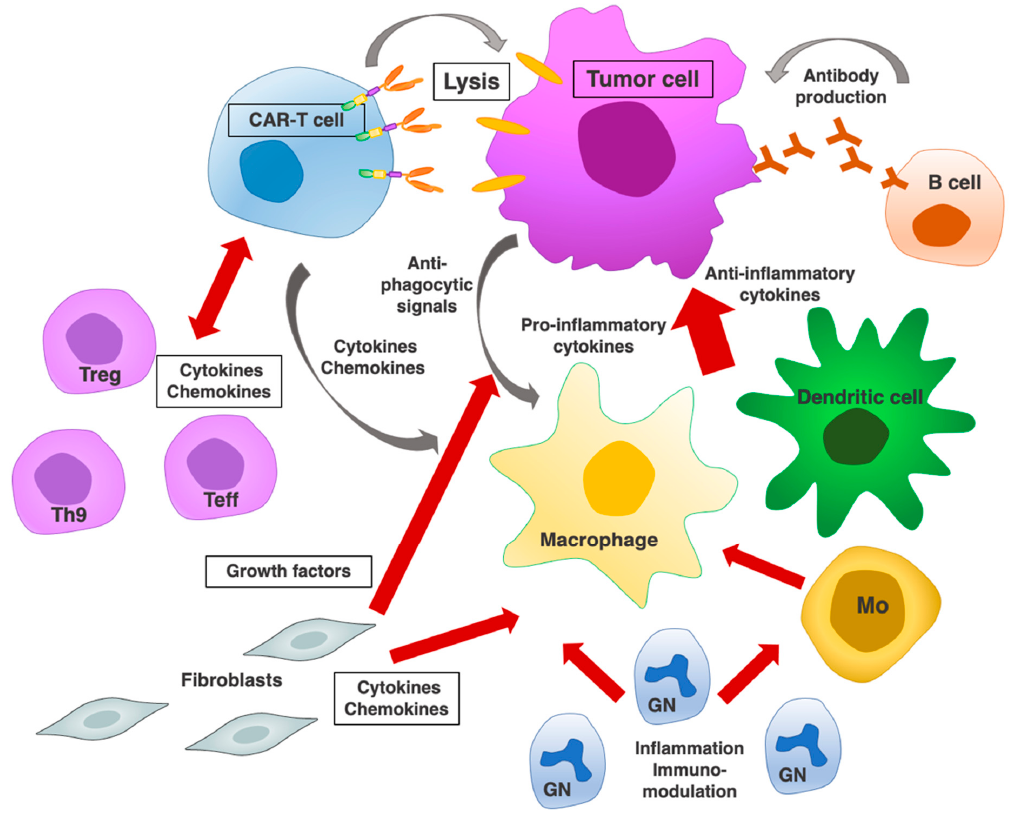
Figure 5. CAR-T cells can trigger endogenous tumor-specific immune response. CAR-T cell activation increases infiltration by dendritic cells, macrophages, and B cells in the target tumor. Additional infiltrating populations include granulocytes (GN), monocytes (Mo), T helper cells (Th9), T effectors (Teff), and T regulatory cells (Treg). Key interactions of infiltrating immune cell populations with cancer cells are mediated by soluble cytokines/chemokines, among them CCL/CCR, IL-2, IL-10, IL-35, TGF- β (Treg, Teff, B cells), CSF1/CSF1R, CCL2/CCR2, IL-10 (TAM), IL-2, IL-15, IL-18, IL-21 (NK), HGF, IGF1, CTGF, PDGF, VEGF, LIF, cytokines, chemokines, BMP4, TGF- β (CAF), and inflammatory mediators (TAM, GN, CAF) [101]. The cell–cell interactions are described in detail in each reference section.